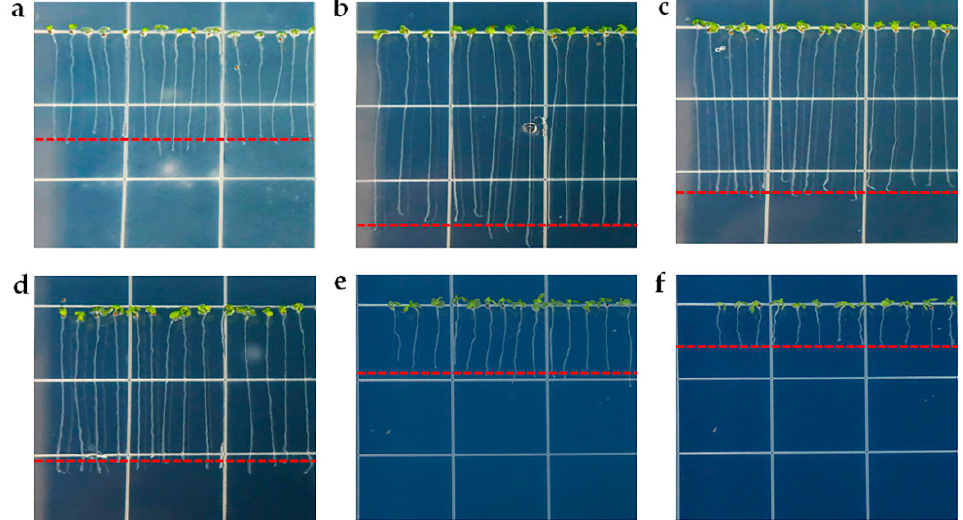
Figure 3. PAW effects on root length during the developmental stage of Arabidopsis thaliana L. Seedlings were vertically grown for 15 days on agar medium. ( a ) DW, ( b ) PAW5, ( c ) PAW7, ( d ) PAW12. ( e ) PAW19, ( f ) PAW40. One square size indicates 2 × 2 cm.